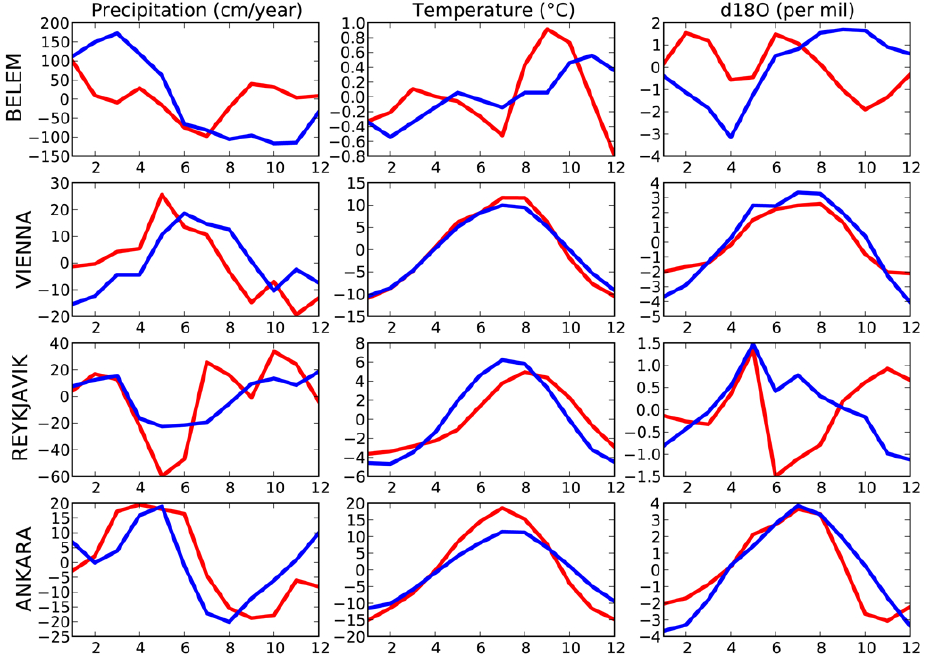
Fig. 5. Seasonal temperature, precipitation and δ 18 O evolution in precipitation at specific stations (Belem, Vienna, Reykjavik and Ankara) in i LOVECLIM from monthly data. The blue line is data from the IAEA (IAEA, 2006) and the red line is i LOVECLIM at the corresponding latitude and longitude. All data are normalised around their annual